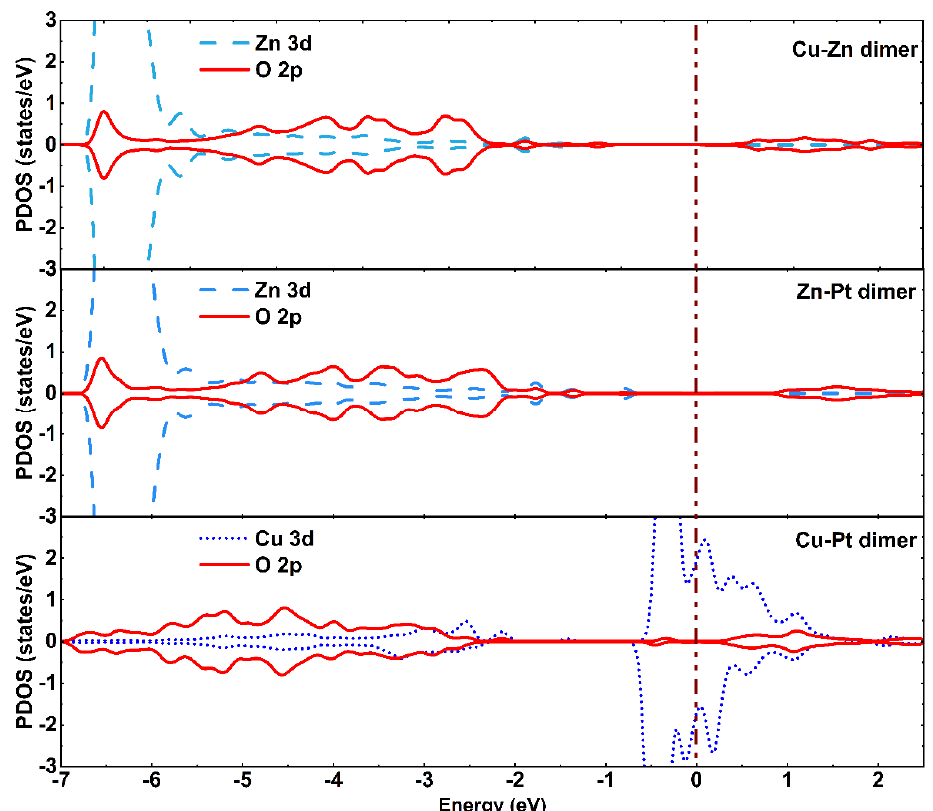
Figure 2. Partial density of states for the bimetal-TiO 2 system (bimetallic dimers are Zn-Cu, Zn-Pt, and Cu-Pt). The Fermi level was set to zero and is marked with a grown dashed line.